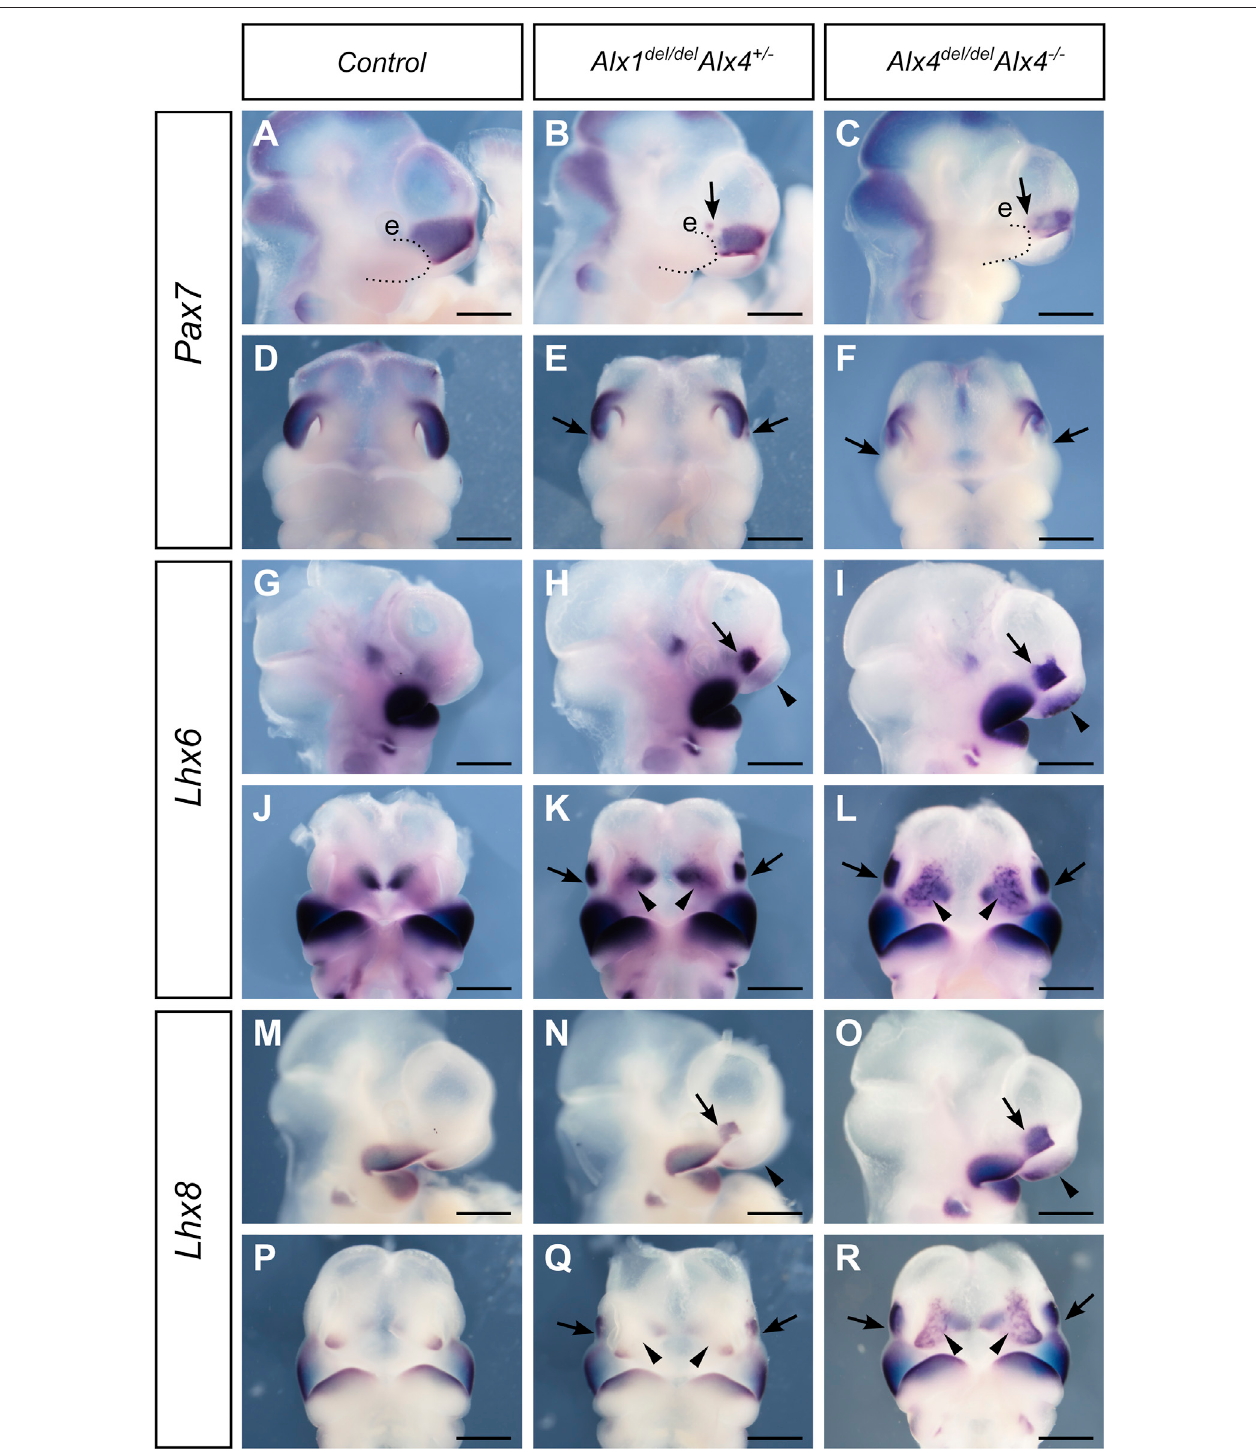
FIGURE 9 | ALX4 partly complements ALX1 function in regulating frontonasal development. Lateral (A – C) and frontal (D – F) views of whole mount embryo heads showing patterns of Pax7 mRNA expression in the control (A, D) , Alx1 del/del Alx4 +/- (B, E) , and Alx1 del/del Alx4 − / − (C, F) embryos at E10.5. Arrow points to the domain of reduced Pax7 expressioninthelateralnasalprocessofthe Alx1 del/del Alx4 +/- (B,E) and Alx1 del/del Alx4 − / − (C,F) embryos,respectively. (G – L) L ateral (G – I) andfrontal (J – L) viewsof whole mount embryo heads showing patterns of Lhx6 mRNA expression in the control (G, J) , Alx1 del/del Alx4 +/- (H, K) , and Alx1 del/del Alx4 − / − (I, L) embryos atE10.5.Arrowsandarrowheadspointtothedomainofectopic Lhx6 expressioninthelateralandmedialnasalprocesses,respectively,intheinthe Alx1 del/del Alx4 +/- (H,